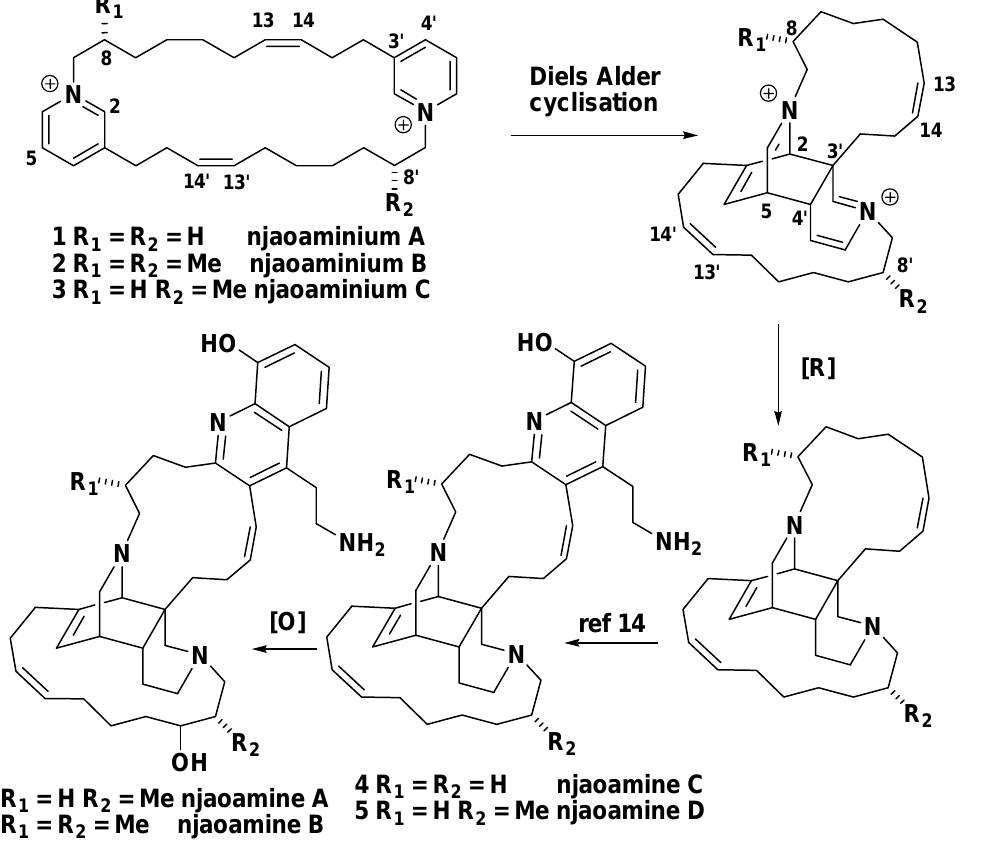
Figure 3. A . Experimental CD spectrum of 3 ; B . Experimental CD spectrum of 2 ; C. Calculated CD spectra of ( S )- 3 , ( R )- 3 , ( R,R )- 2 , and ( S,R )- 2 in MeOH (moved 57 nm